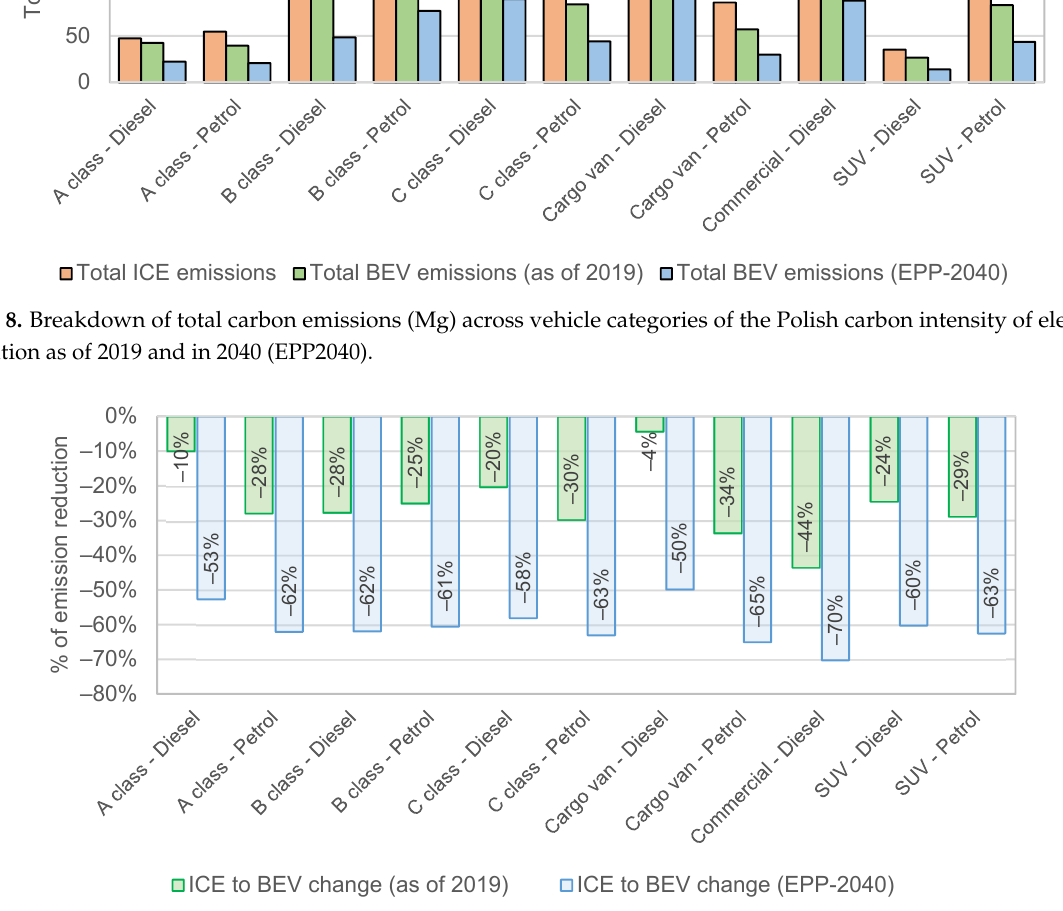
Figure 9. Breakdown of emission reductions (%) for the Polish carbon intensity of electricity generation as of 2019 and in 2040 (EPP2040).